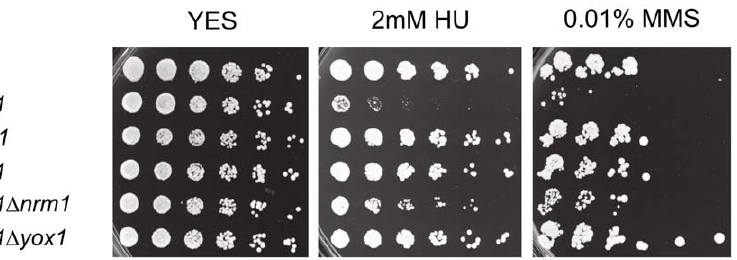
Figure 5. Inactivation of Yox1 following genotoxic stress is essential for cell survival. Five-fold serially dilution of wt, cds1 D , D nrm1 , yox1 D , cds1 D nrm1 D and cds1 D yox1 D cells were spotted onto YES or YES plus indicated concentrations of HU or